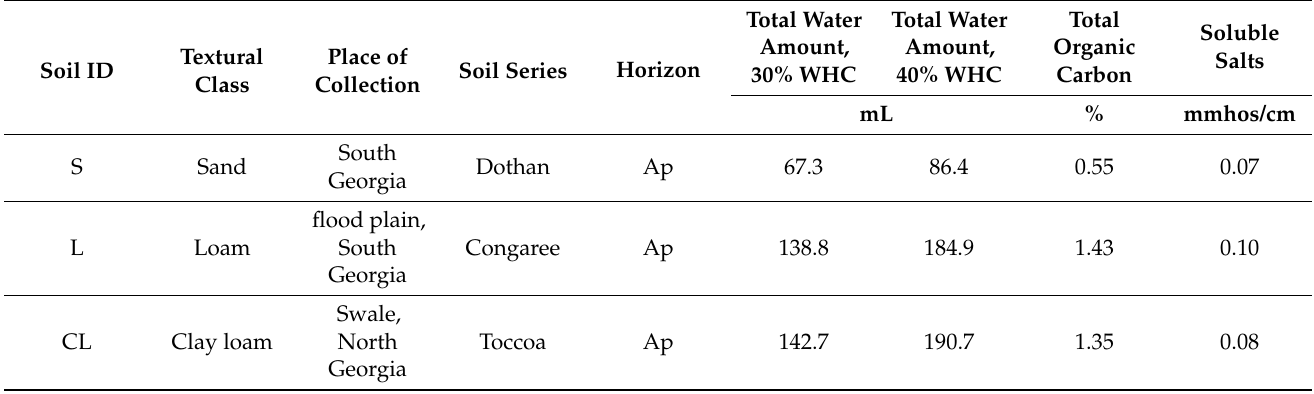
Table 1. Soil properties and locations where the soils used in the study were collected. Moisture content refers to the total water amount retained in the soil at the specified WHC. Abbreviations: Ap: plowed A horizon; WHC: water holding